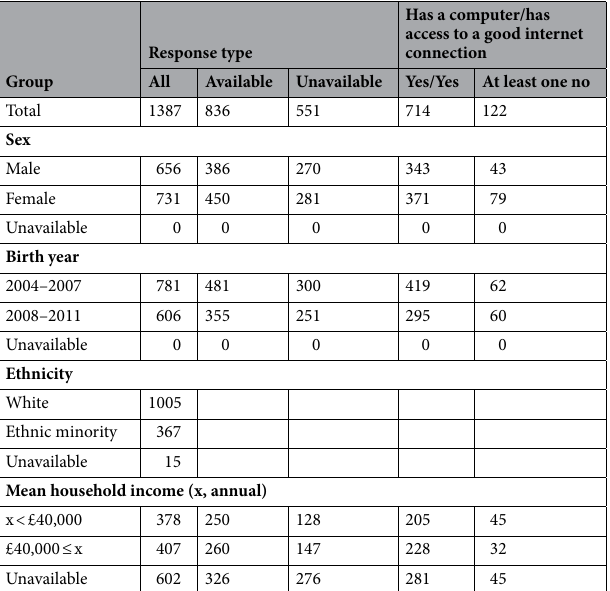
Table S1. Of the 1387 included participants, 836 (60.3%) had a valid response to the digital inclusion question. Table 1 shows the sociodemographic characteristics of participants in relation to their responses to the digital inclusion question.